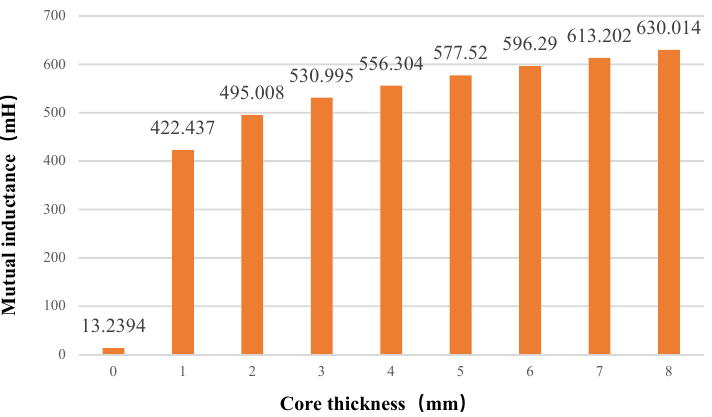
Figure 11. Variation curve of mutual inductance during offset under different core thicknesses.